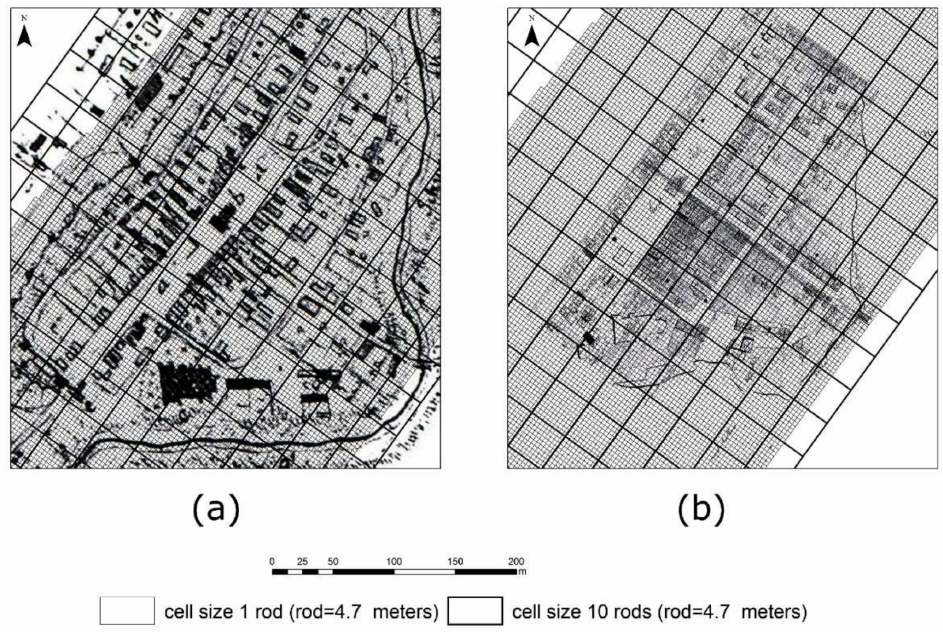
Figure 8. Comparison of the grid created using HGIS Tools for the Gründ Riss der Stadt Neuteich (Town plan) 1710, before the fire of year 1711 ( a ) and Plan von der Königlichen Immediat Stadt Neuteich (Town plan) 1802, after the regulation of the city ( b